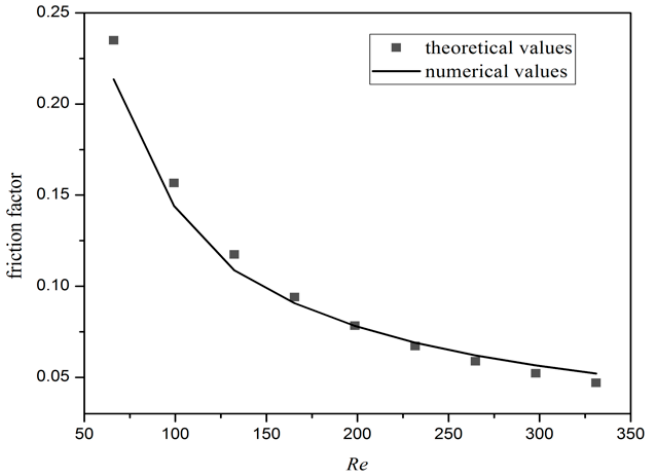
Figure 4. Variation of the friction factor vs. Reynolds number for DL-R micromachine structure.